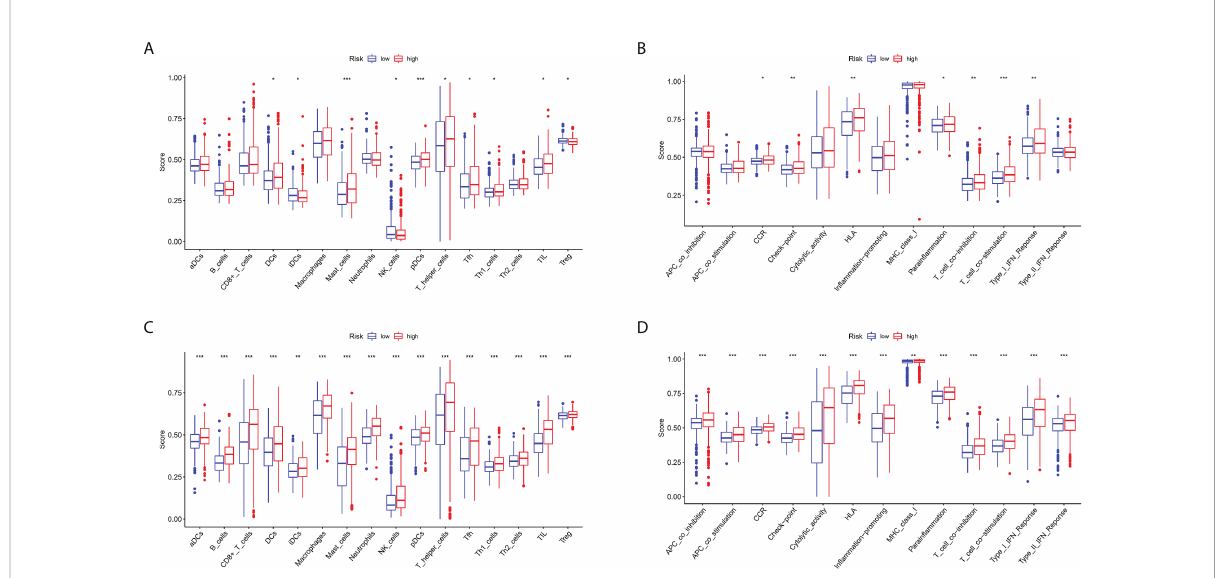
FIGURE 9 Comparison of the ssGSEA scores for immune cells and immune pathways. (A, B) Comparison of the enrichment scores of 16 types of immune cells and 13 immune-related pathways between low- (green box) and high-risk (red box) group in the TCGA cohort. (C, D) Comparison of the enrichment scores of 16 types of immune cells and 13 immune-related pathways between low- (green box) and high-risk (red box) group in the GEO cohort. * P <0.05, ** P <0.01, *** P